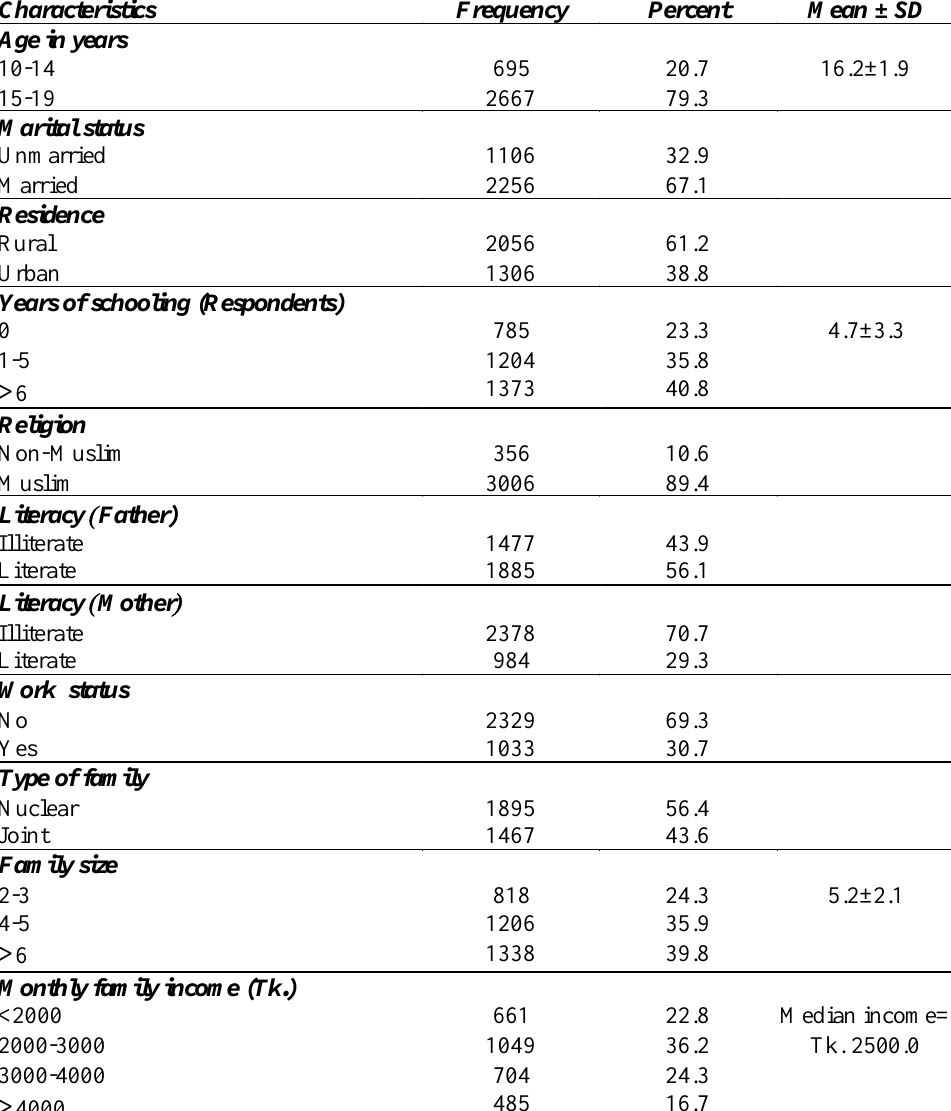
Table I : Socio-demographic characteristics of the adolescents (N=3362) Characteristics